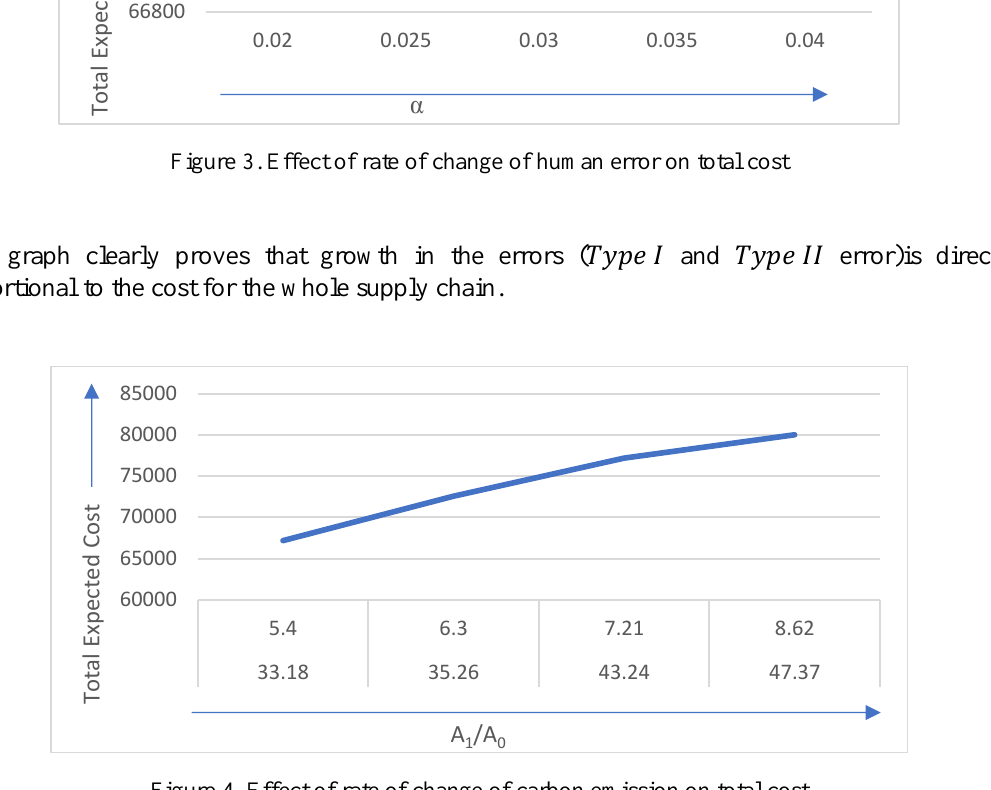
Figure 4. Effect of rate of change of carbon emission on total